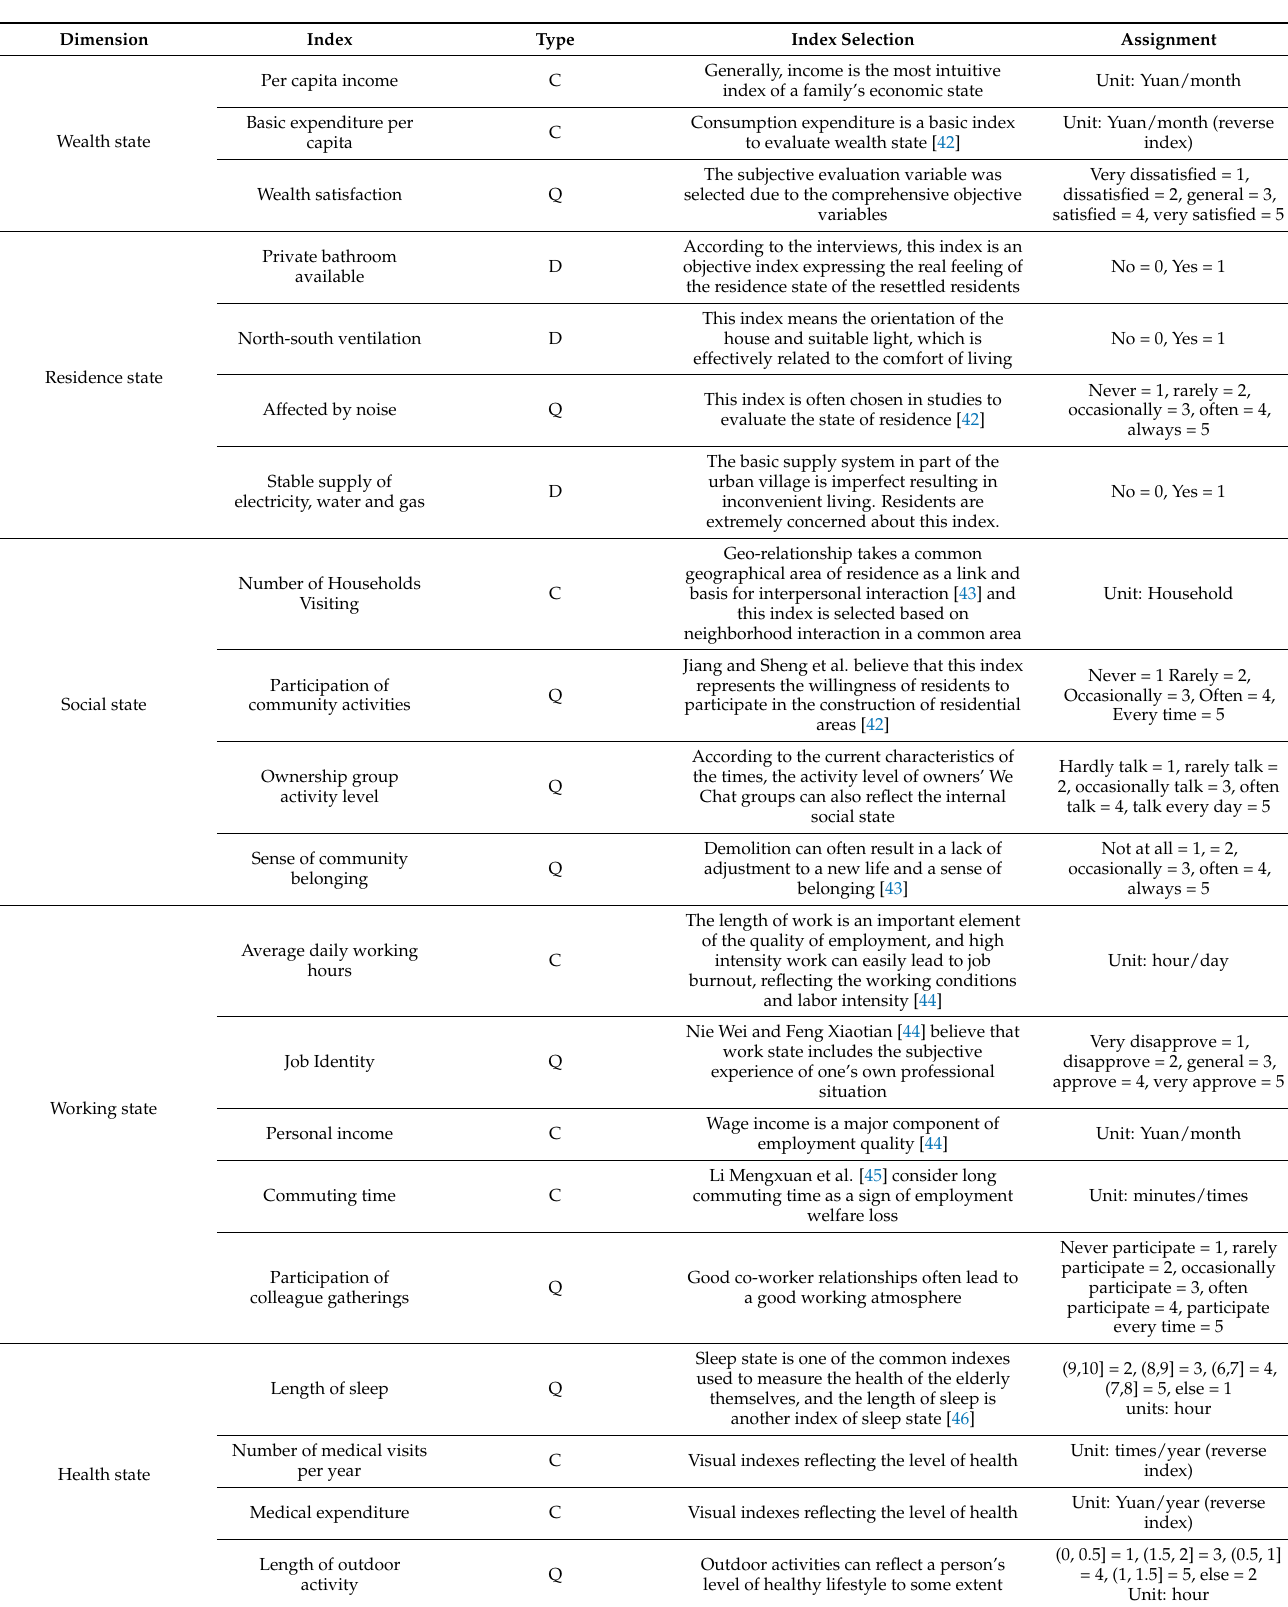
Table 1. Index selection basis and